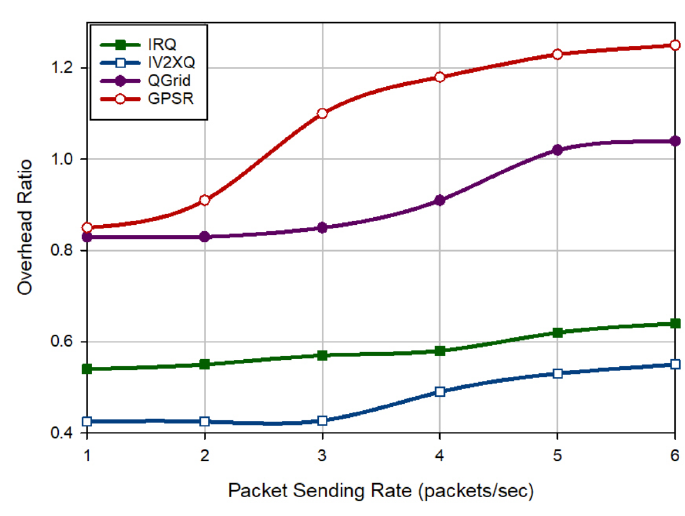
Figure 10. Comparison of routing overhead in different methods based on PSR.